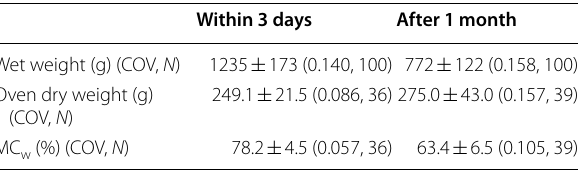
Table 2 Weight and moisture content of waste mushroom bed (mean ±